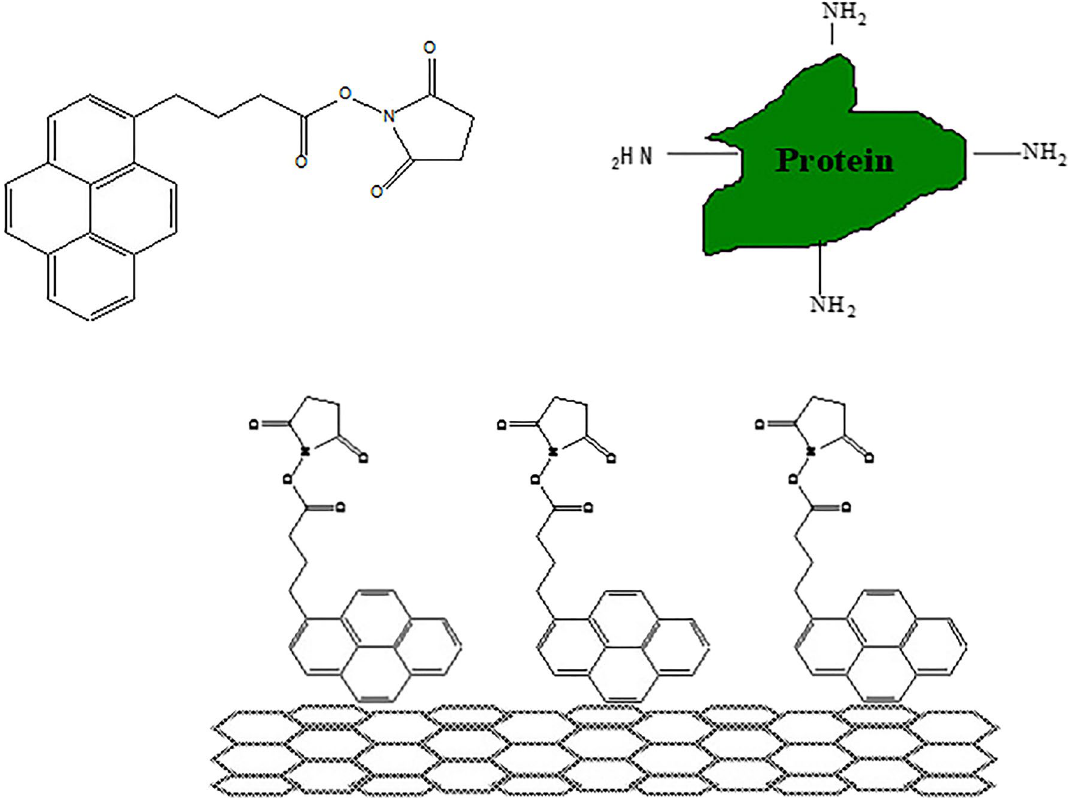
Fig. 2 1-Pyrenebutanoic acid, succinimidyl ester 1 irreversibly absorbing onto the sidewall of a SWNT